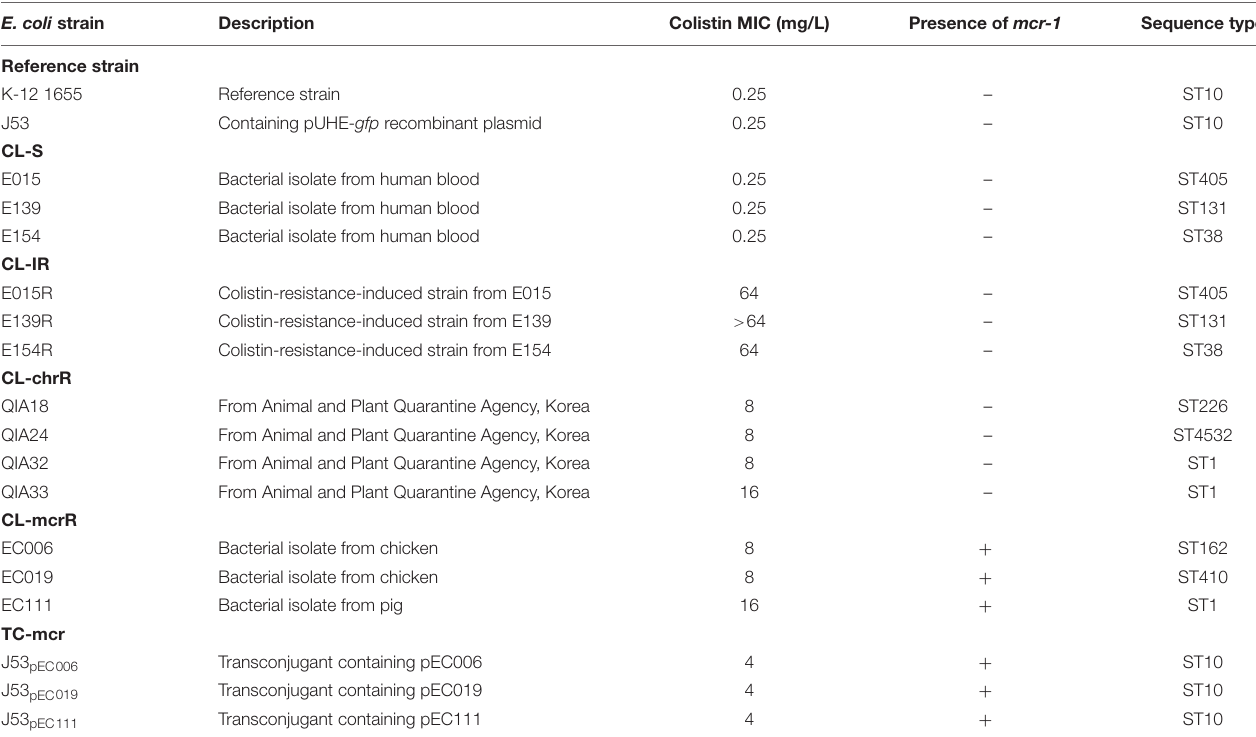
TABLE 1 | Bacterial strains used in this